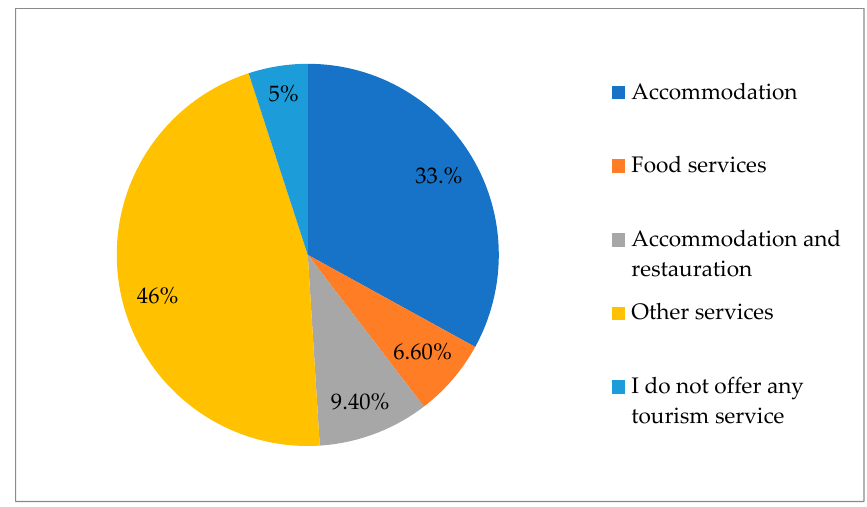
Figure 1. Type of tourism service offered by the local respondents during the festival .